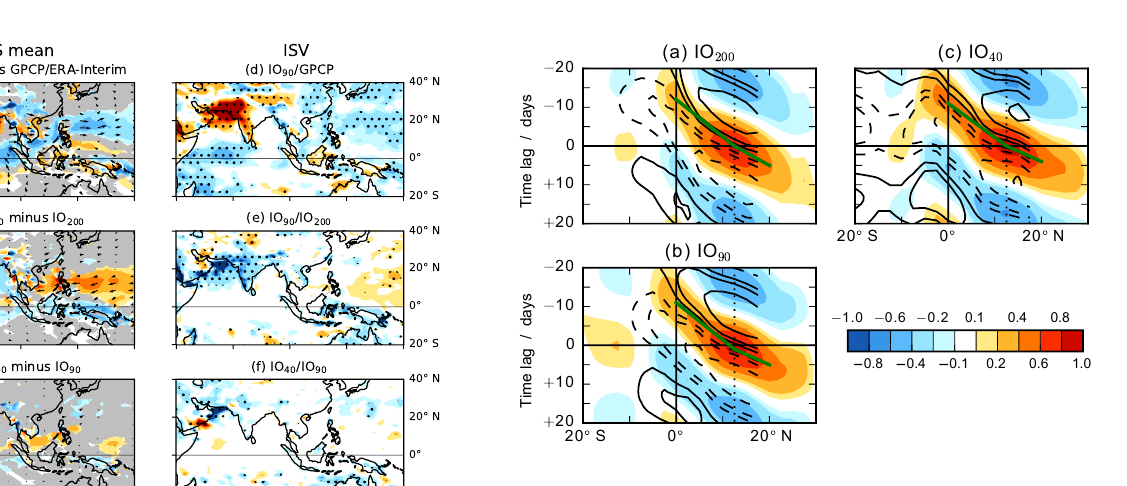
Figure 14. As Fig. 6 but for (a) IO 200 , (b) IO 90 (repeat of Fig. 6e, for reference), (c) IO 40